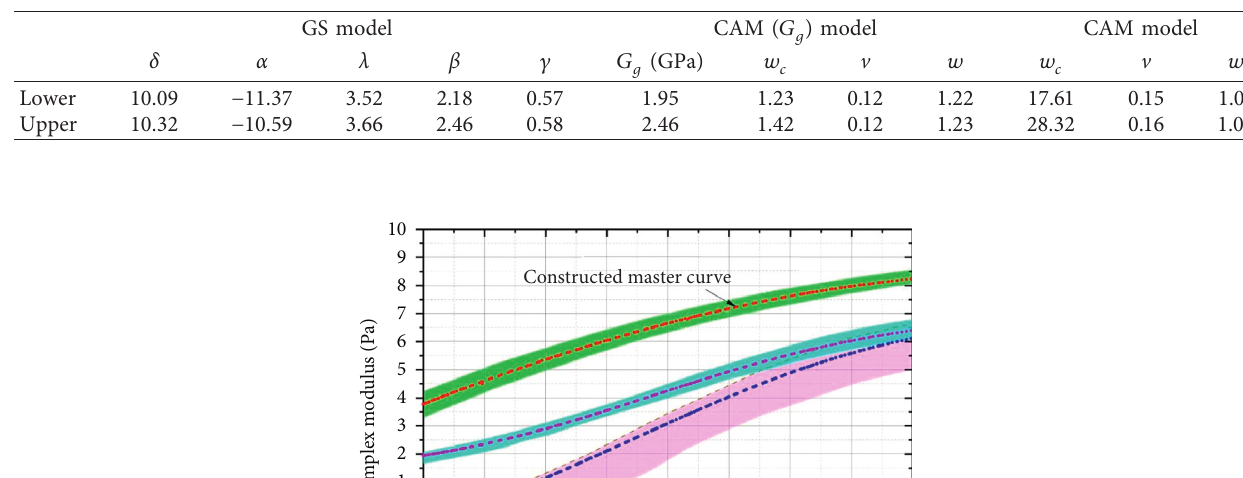
Table 1: Estimated parameter intervals of U15 at confidence level 95%.